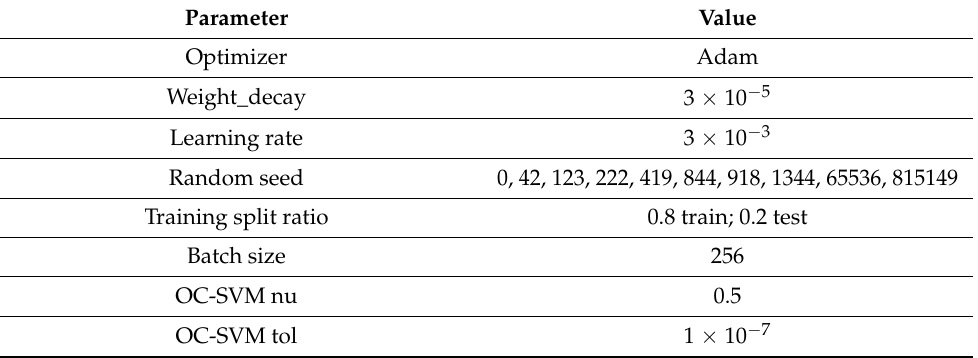
Table 4. Training